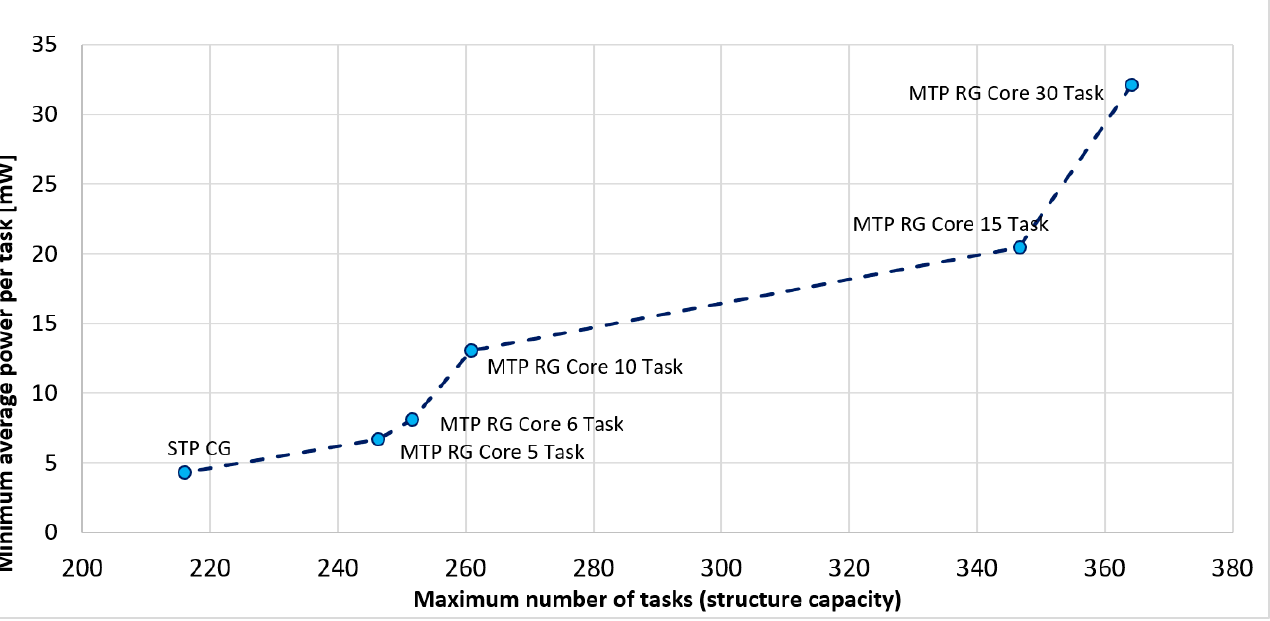
Figure 16. Relationship between the maximum number of processed tasks (system capacity) and the minimum possible value of the power per task for a Xilinx Virtex 7 device. The points are denoted by scenario type (configurations).